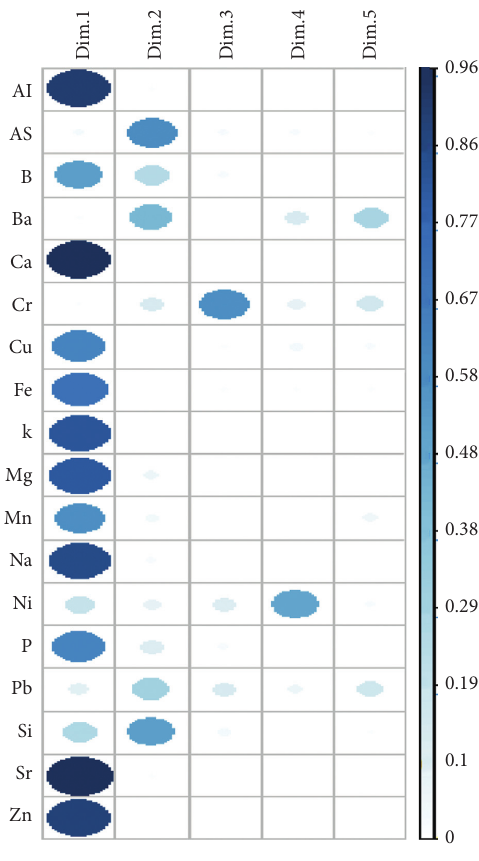
Figure 4: Distribution of metals by size. Table 3: Phytochemical screening of leaves and stems of the species Origanum grosii. — Leaves Stems